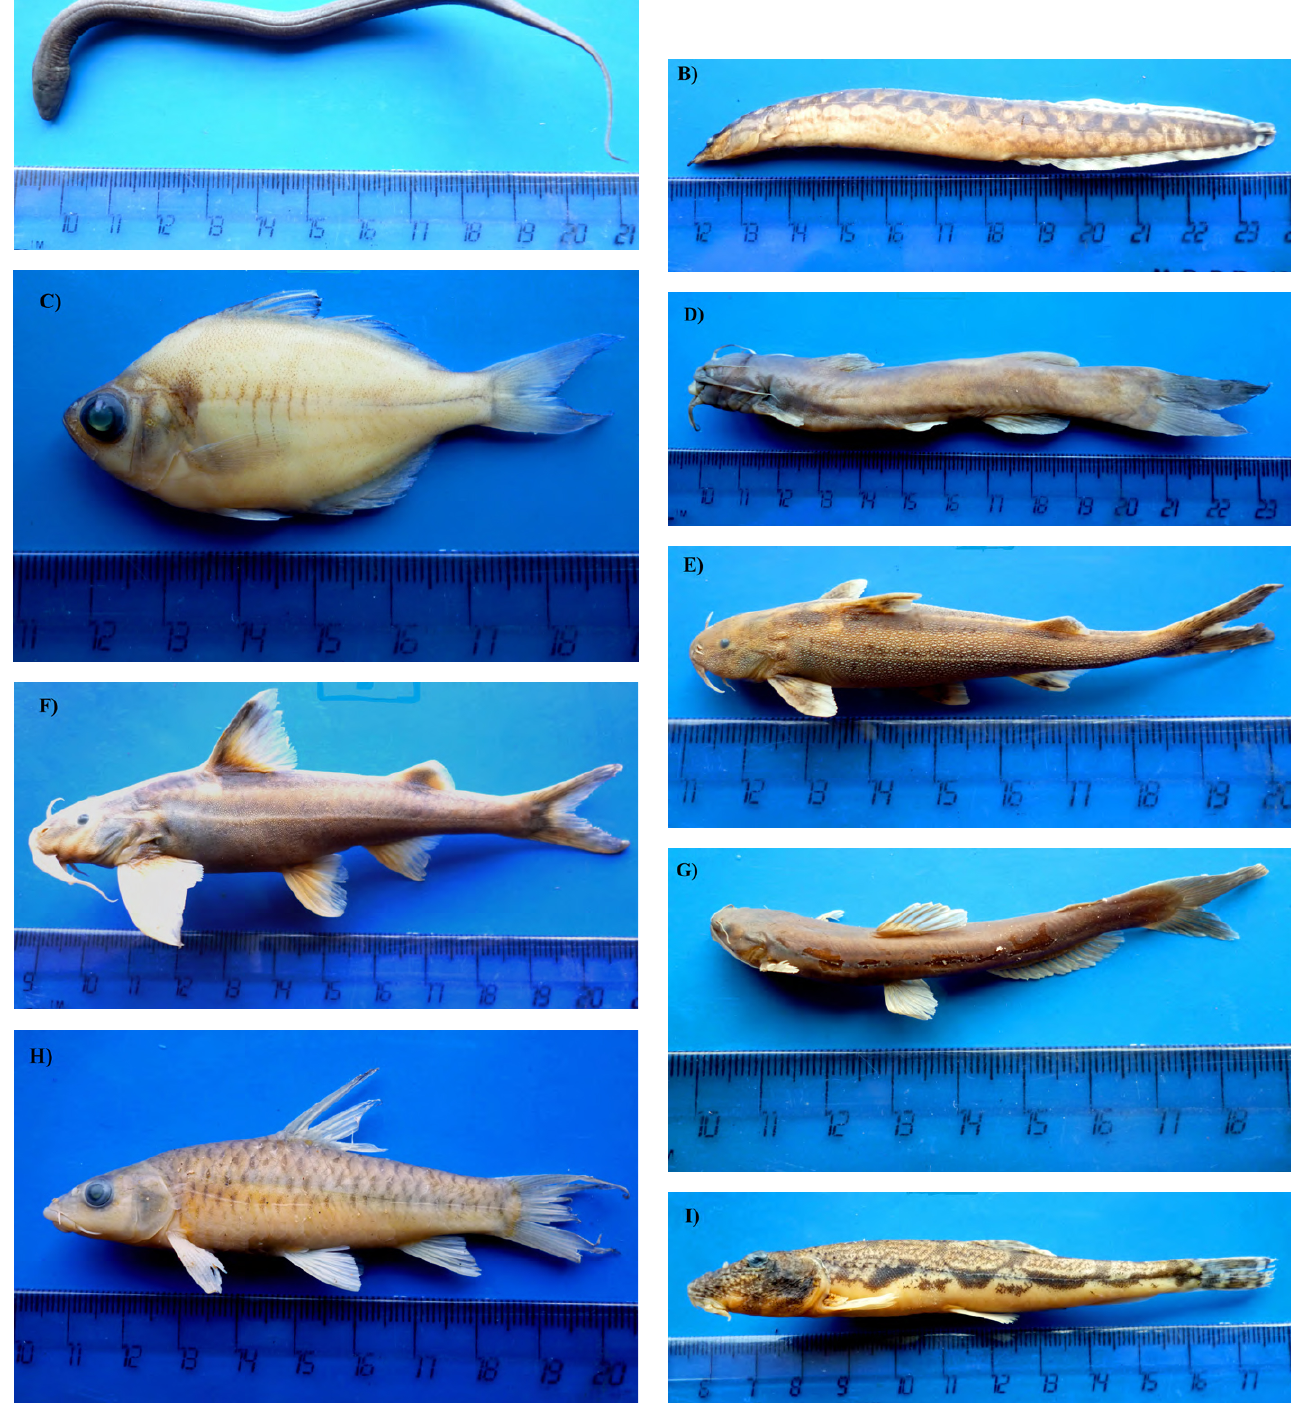
Figure 2. Indigenous fishes collected from April 2012 to March 2014 in the Ranganadi River. A : Anguilla bengalensis . B : Mastacembelus armatus . C : Parambassis baculis . D : Amblyceps arunchalensis . E : Glyptothorax telchiita . F : Glyptothorax trilineatus . G : Olyra kempi . H : Tor tor . I : Canthophrys gongota